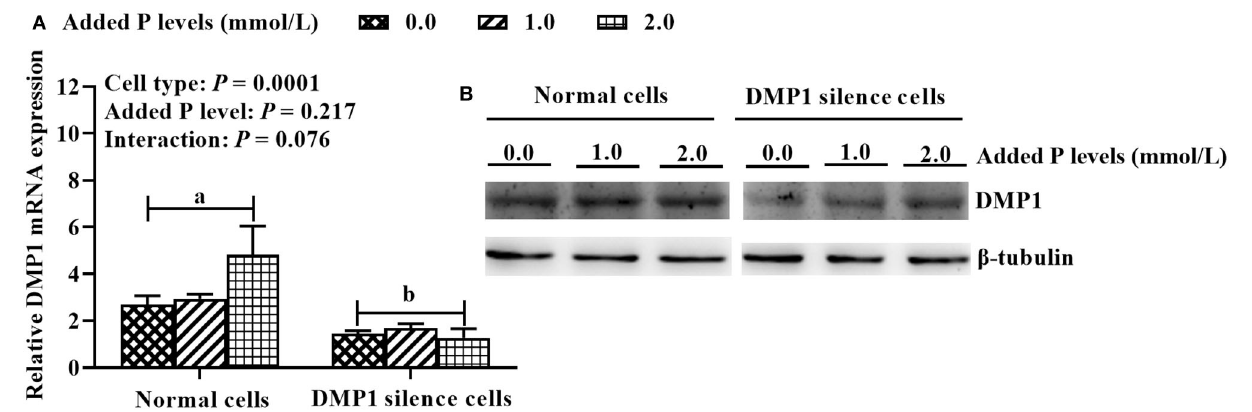
FIGURE 4 | DMP1 silencing model for primary cultured tibial osteoblasts of broiler chicks under different P levels (experiment 3). (A) DMP1 mRNA expression; (B) DMP1 protein expression. Relative mRNA expression of DMP1 was calculated using the 2 − 11 Ct method, and the data were normalized by the geometric mean of two internal reference genes β -actin and GAPDH . The β -tubulin protein was used to normalize the expression level of target protein. All values are expressed as means ± SE, n = 6. Means without a common letter differ, P < 0.05. DMP1 , dentin matrix protein